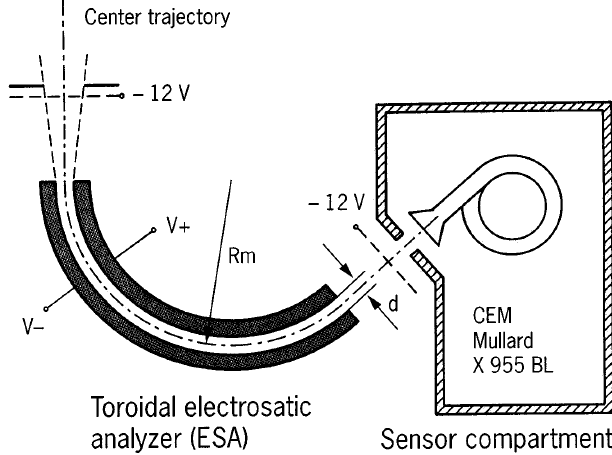
Fig. 1. General design principle of the electron